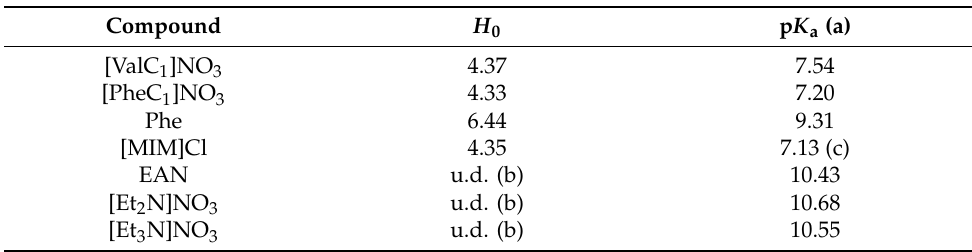
Table 5. The Hammett acidity functions ( H 0 ) and p K a values of some [AAE]X and the contrastive compounds in